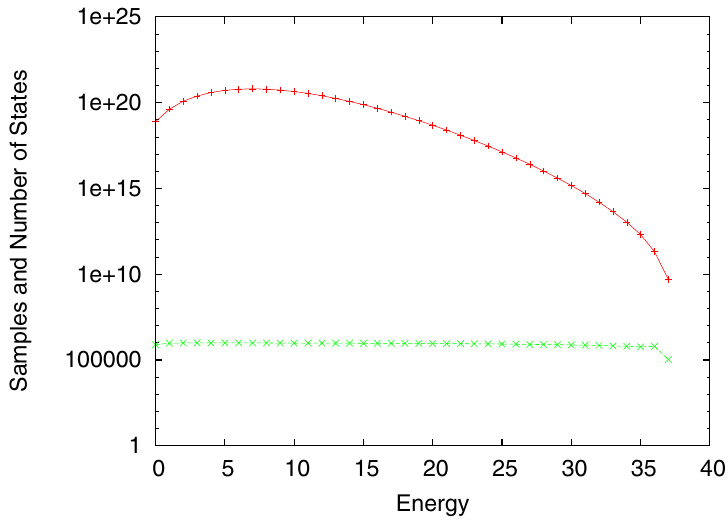
Fig. 6. Number of States of Interacting Self-Avoiding Walks with 50 steps at fixed energy estimated from 10 6 flatPERM tours. The lower graph shows the number of actually generated samples for each